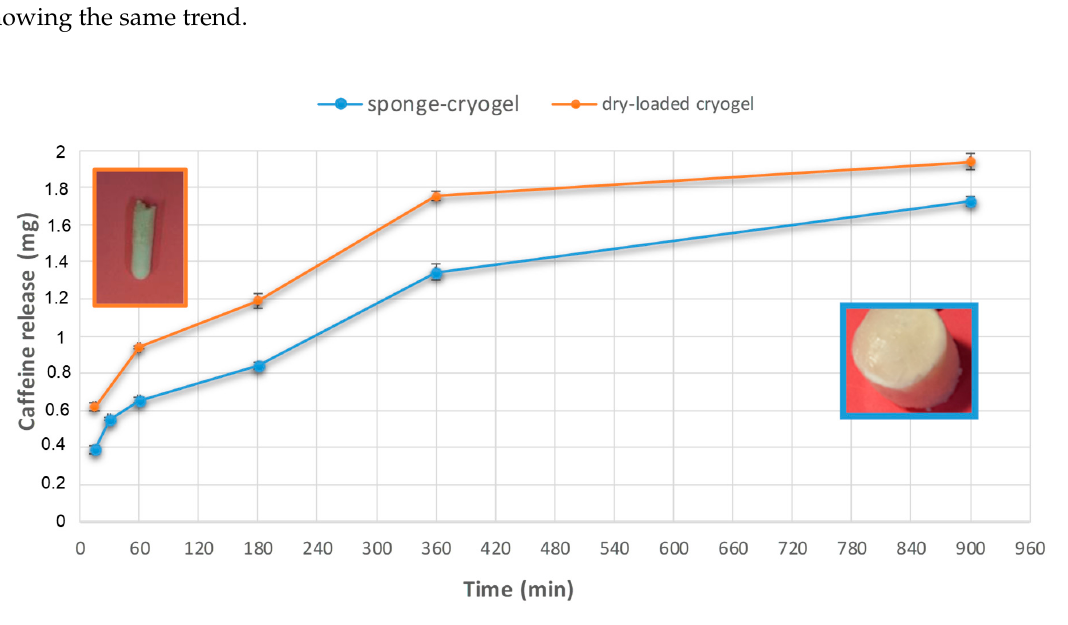
Figure 6. Percentage/mg medium values of the cumulative caffeine release versus time (standard deviation bars are reported) for the sponge cryogel and dry-loaded sample.